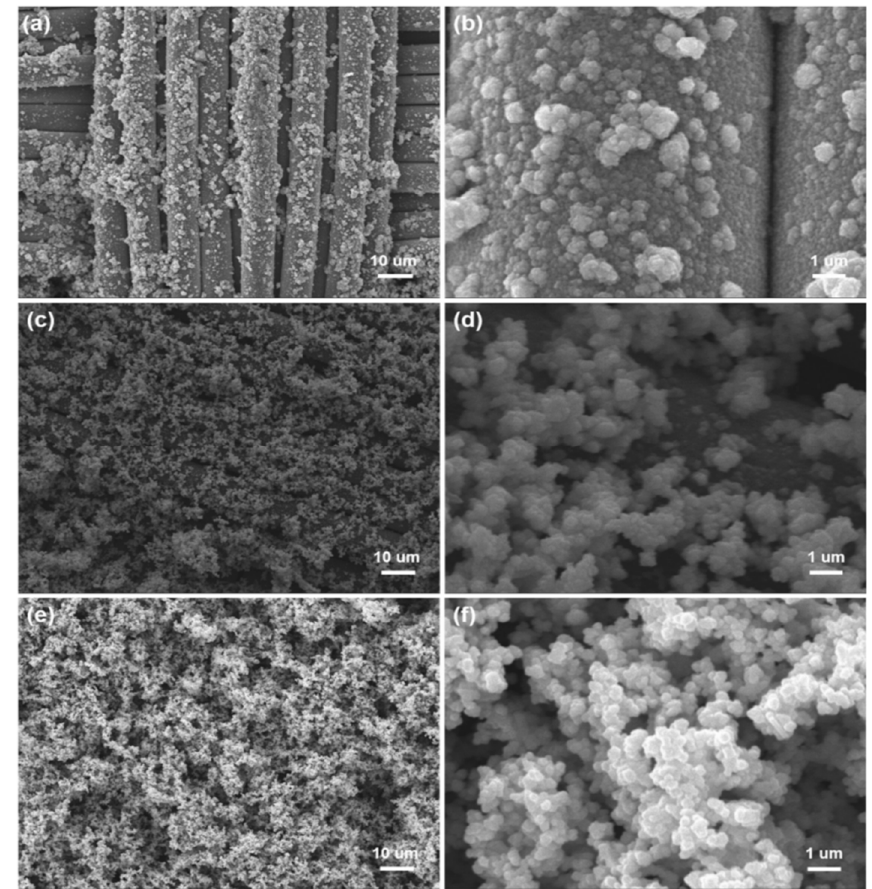
Figure 3. SEM images of Cu/Ag/PDA/PET fabrics with different magnifications: ( a , b ) reaction time of 2 h; ( c , d ) reaction time of 4 h; and ( e , f ) reaction time of 6 h.